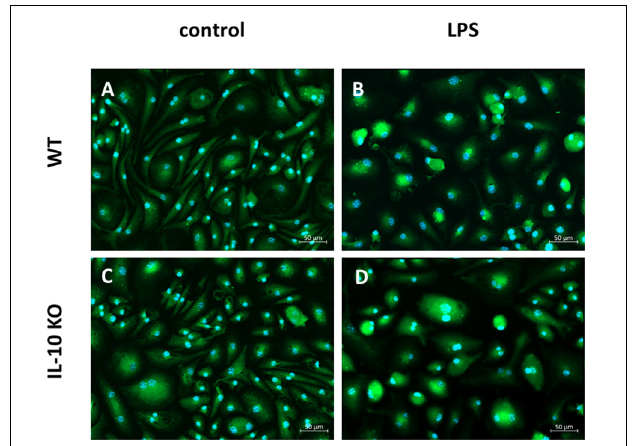
FIGURE 1 | Fluorescence microscopy of Iba1+ WT and IL-10 KO microglia. (A) WT (control), (B) WT (LPS); slim cell bodies, (C) IL-10 KO (control), (D) IL-10 KO (LPS), round, amoeboid cell shape. Representative figures of four independent experiments ( n = 4); overlay Iba1/green, nuclei/blue, 200-fold